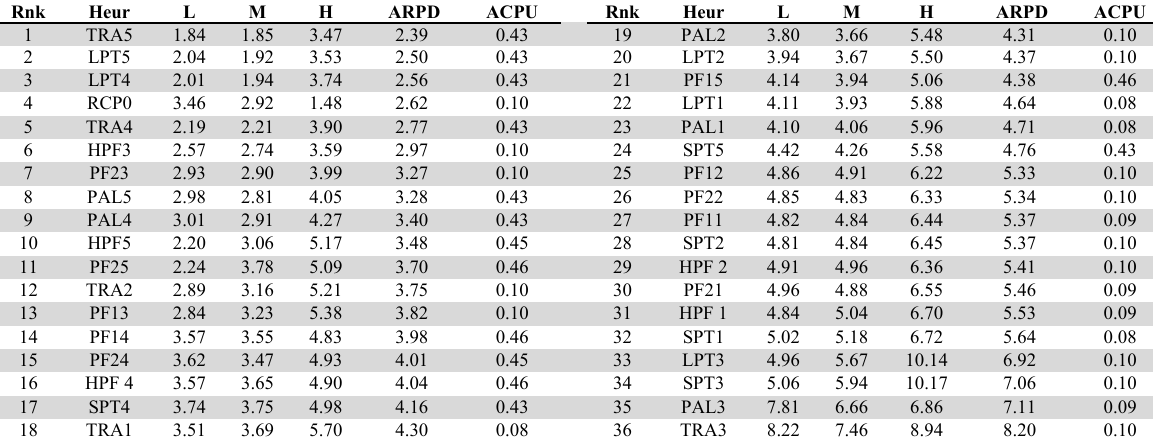
ARPD and ACPU of heuristics ordered by